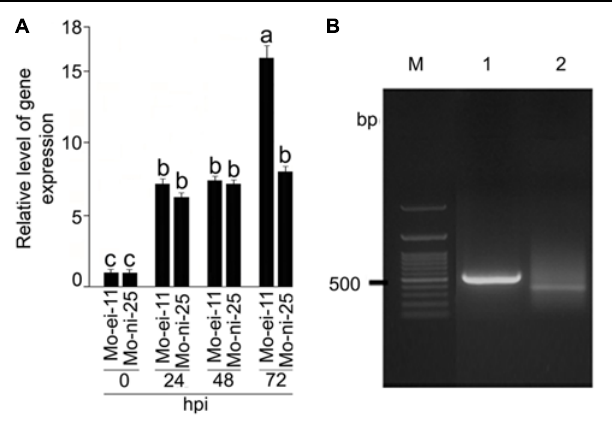
FIGURE 1 | Expression analysis CYP76M7 transcripts and mapping of its Transcription Start Site (TSS). (A) qRT-PCR analysis was performed to analyze the expression of CYP76M7 in response to infection by Magnaporthe oryzae isolate Mo-ei-11 and Mo-ni-25 at 24, 48, and 72 hpi. Values represent mean ± SE. Means with significant deference from each other ( α = 0.05) is represented with different superscripts according to Tukey’s test. (B) 5 (cid:2) RACE (Rapid Amplification of cDNA End) PCR; M: 100 bp GeneRuler (Fermentas) 1: Positive control (provided with the kit), 2: CYP76M7